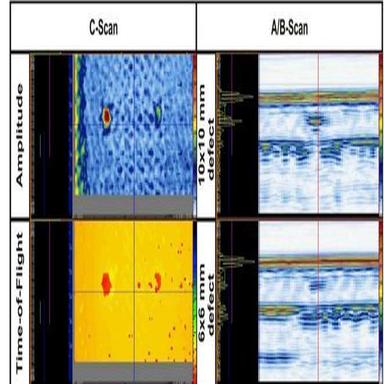
Ultrasonic investigation of panel 3.